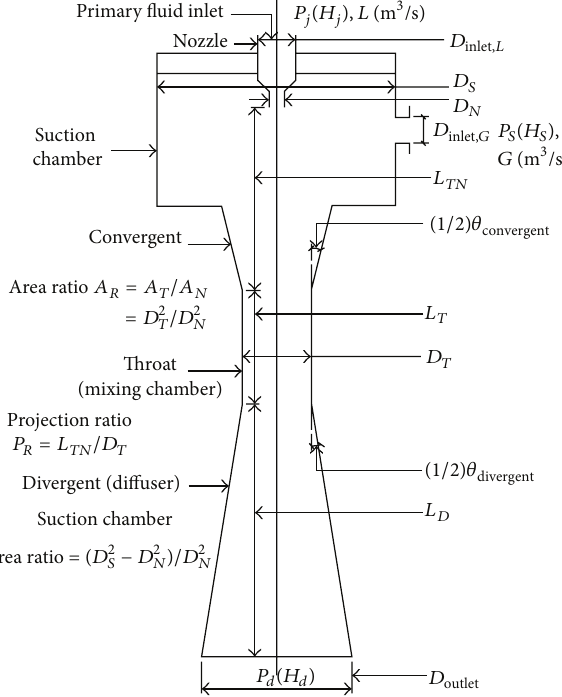
Figure 2: Schematic diagram showing geometry of an ejector [31, 111,